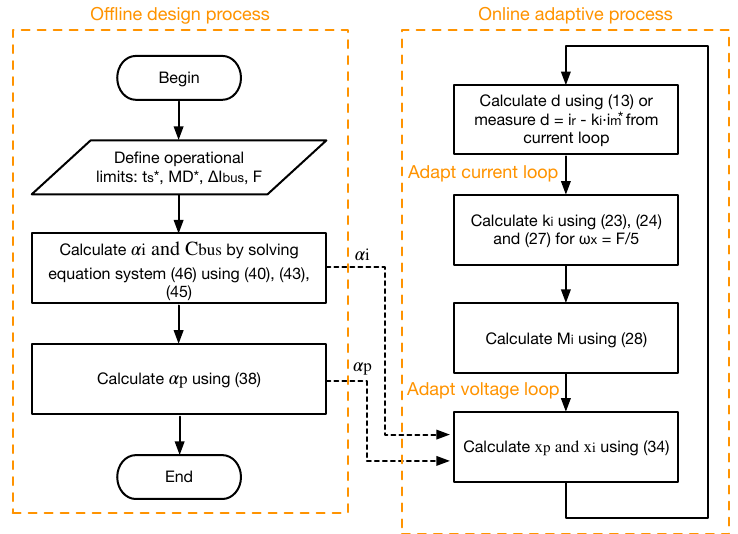
Figure 4. Flowchart of both design and adaptive